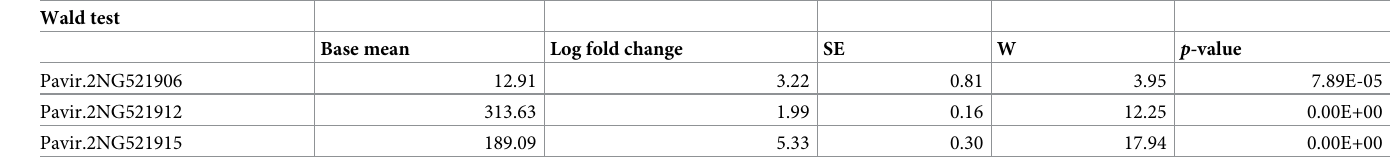
Data underlying this table can be found in S1